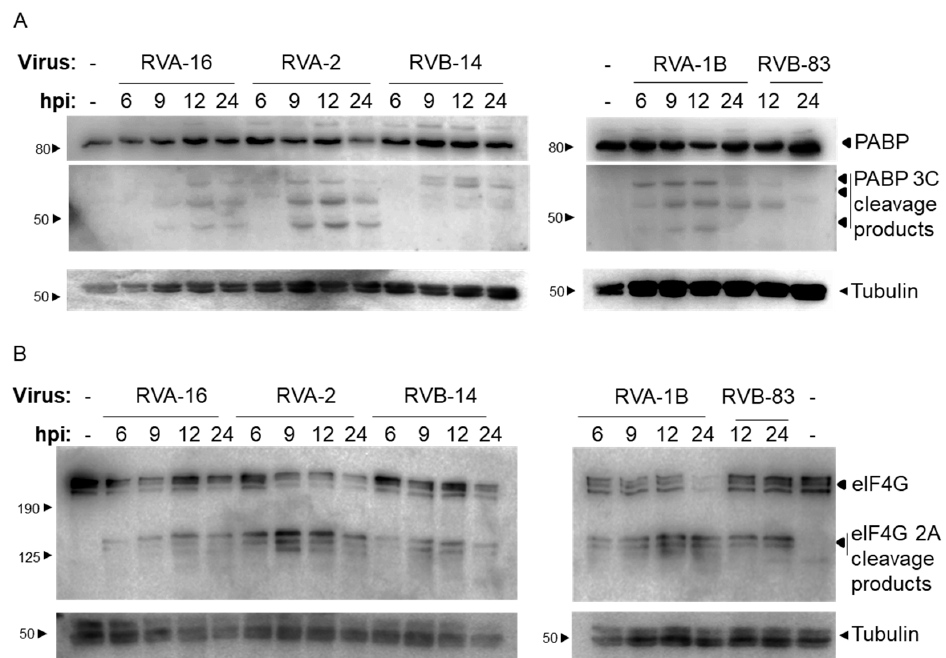
Figure 2. RV protease activity correlates with RIPK1 cleavage. O-HeLa cells were infected with the RV strains as per Figure 1. Protein lysates were collected at the indicated times and subject to SDS-PAGE, transferred to nitrocellulose membrane and blocked. Blots were probed with ( A ) anti-PABP antibodies, or ( B ) anti-eIF4G antibodies. Tubulin was used as a loading control for all blots and is included below the corresponding blots. The position of bands correlating to the indicated full-length protein, or the cleavage products are indicated to the right of the blot. The relevant molecular weights are indicated to the left of the blots. Representative western blots of three independent experiments have been shown. Please note that proteins were separated on 12.5% ( A ) or 8% ( B ) gels.